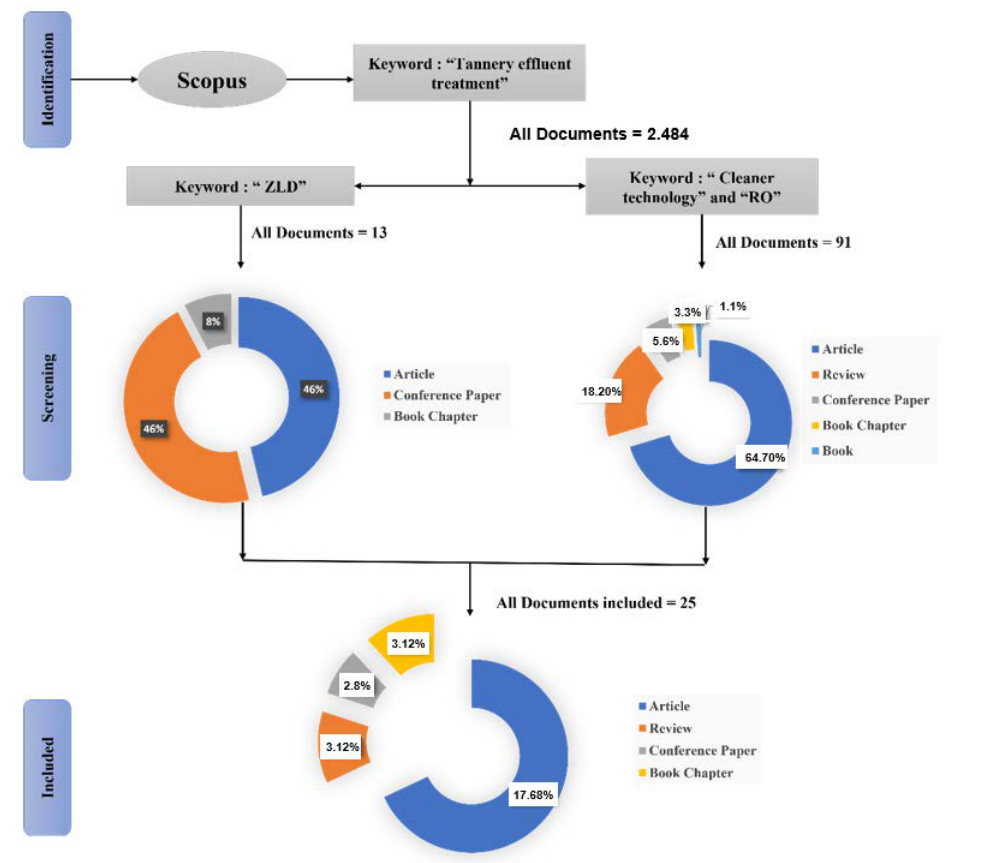
Figure 1. Prisma flow diagram for ZLD system in the tannery